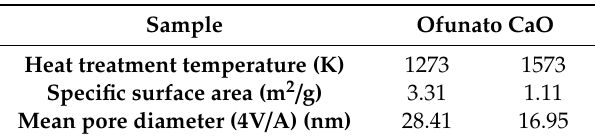
Table 3. Specific surface area and mean pore diameter of Ofunato CaO after decarbonization at 1273 K and 1573 K in muffle furnace.